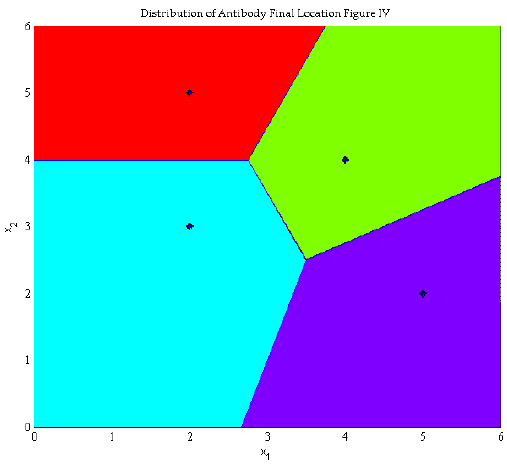
Figure 10. Antibody final position map.